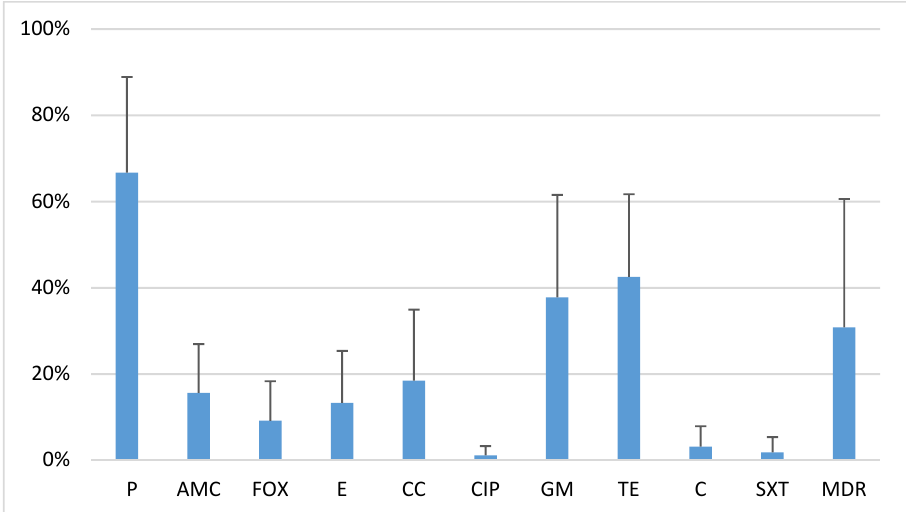
Figure 1. Antibiotic resistance of 110 oral S. aureus strains. P—penicillin; AMC—amoxicillin/clavulanic acid; FOX—cefoxitin; E—erythromycin; CC—clindamycin; CIP—ciprofloxacin; GM—gentamicin; TE—tetracycline; SXT—sulfamethoxazole/trimethoprim; MDR—multidrug resistance.